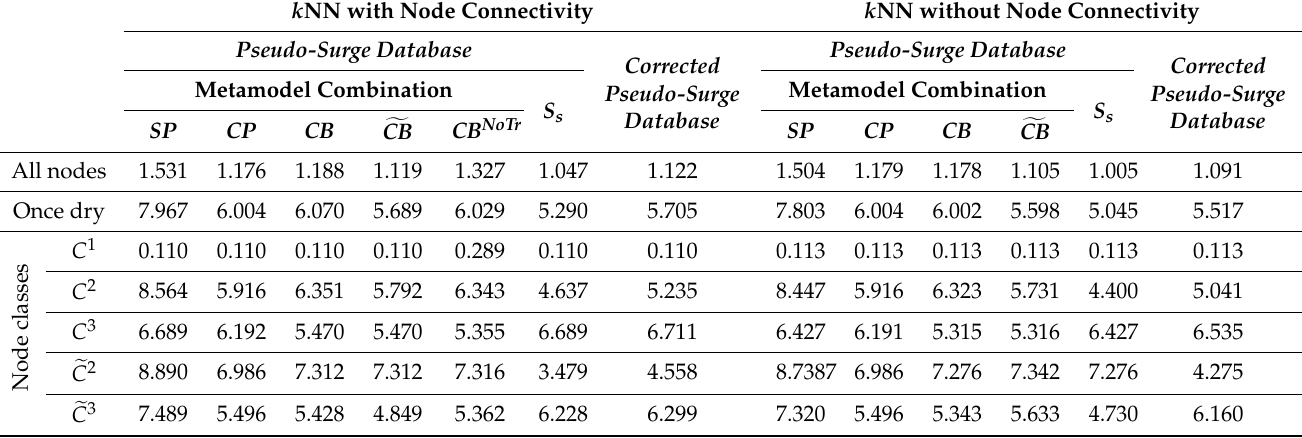
Table 6. False-negative misclassification ( − MC ) percentage for different variants and different groups of